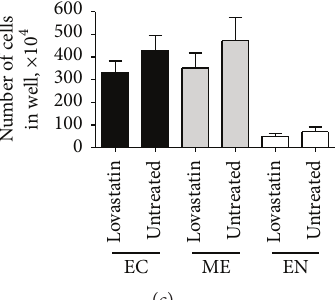
Figure 4: Changes in lovastatin treated and untreated hES cells during differentiation into ectodermal, mesodermal, or endodermal lineages. hEC cells were treated with 20 𝜇 M lovastatin for 48 h; then differentiation into ectodermal, mesodermal, or endodermal lineages was initiated by applying special media. After two days of differentiation, the hES cells were collected, fixed, and stained as described in Figure 1. (b) The expression of single pluripotency markers during differentiation into ectodermal (EC), mesodermal (ME), or endodermal (EN) lineages. Results are shown as mean ± SD ( 𝑛 = 5 ). (c) The number of lovastatin treated and untreated hES cells after two days of differentiation ( 𝑛 = 5